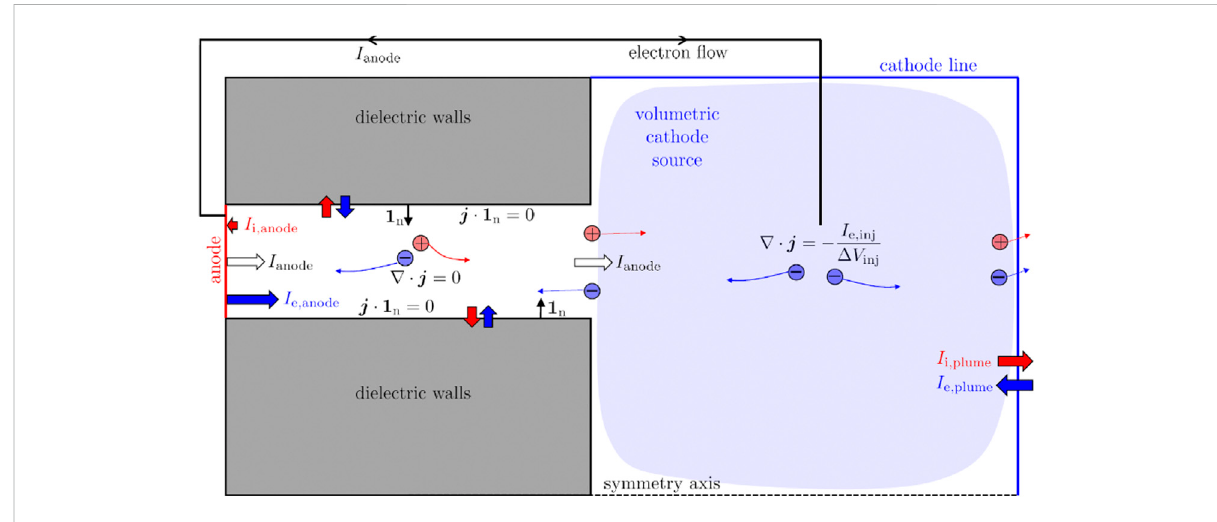
FIGURE 3 Scheme representing the electron injection scheme used in the